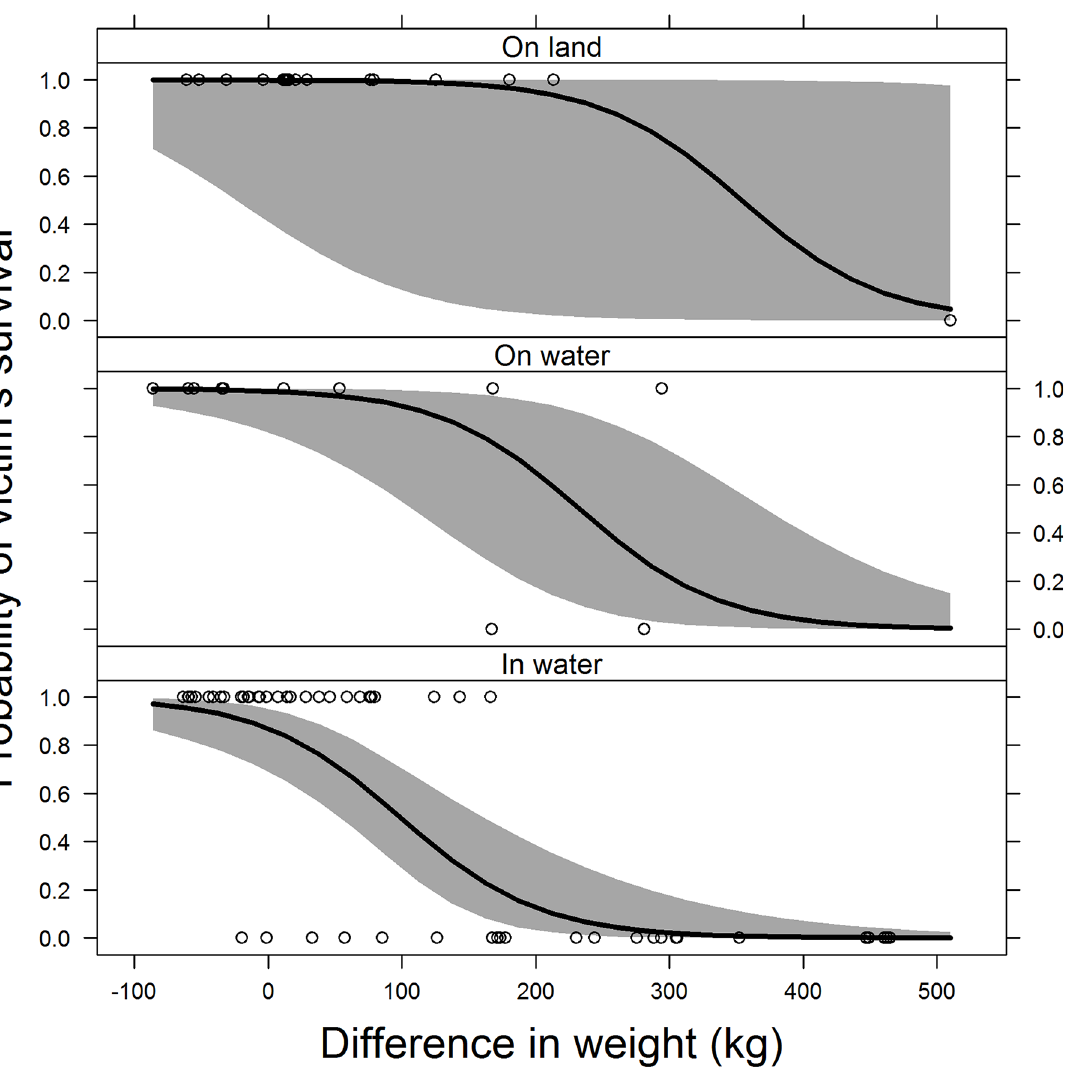
Fig 3. Estimated probability (solid line) that a victim survives a saltwater crocodile attack over the difference in weight between a crocodile and victim in on-land, on-water, and in-water positions. Grey shade is 95% confidence band and open symbols are the raw binary data of crocodile attacks (N =